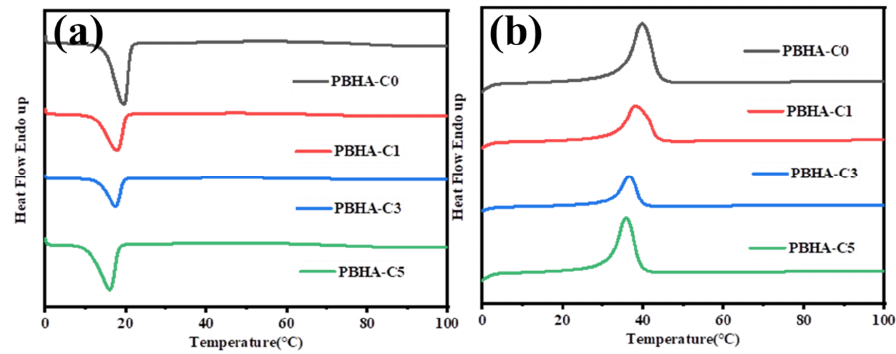
Figure 3. DSC curve of PBHA-Cn copolymers in ( a ) first cooling process and ( b ) second reheating process at the same rate of 10 °C min −1. Table 2. Thermal properties of PBHA-Cn copolymers.